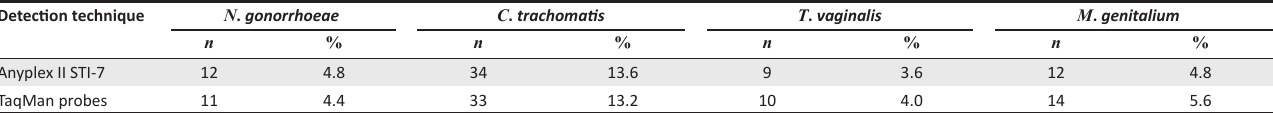
TABLE 1: Yield obtained with Anyplex™ II STI-7 detection assay and TaqMan® probes, from 250 vaginal swab specimens collected from patients attending Prince Cyril Zulu Communicable Disease Centre (Durban, South Africa) between May 2016 and January 2017. Detection technique